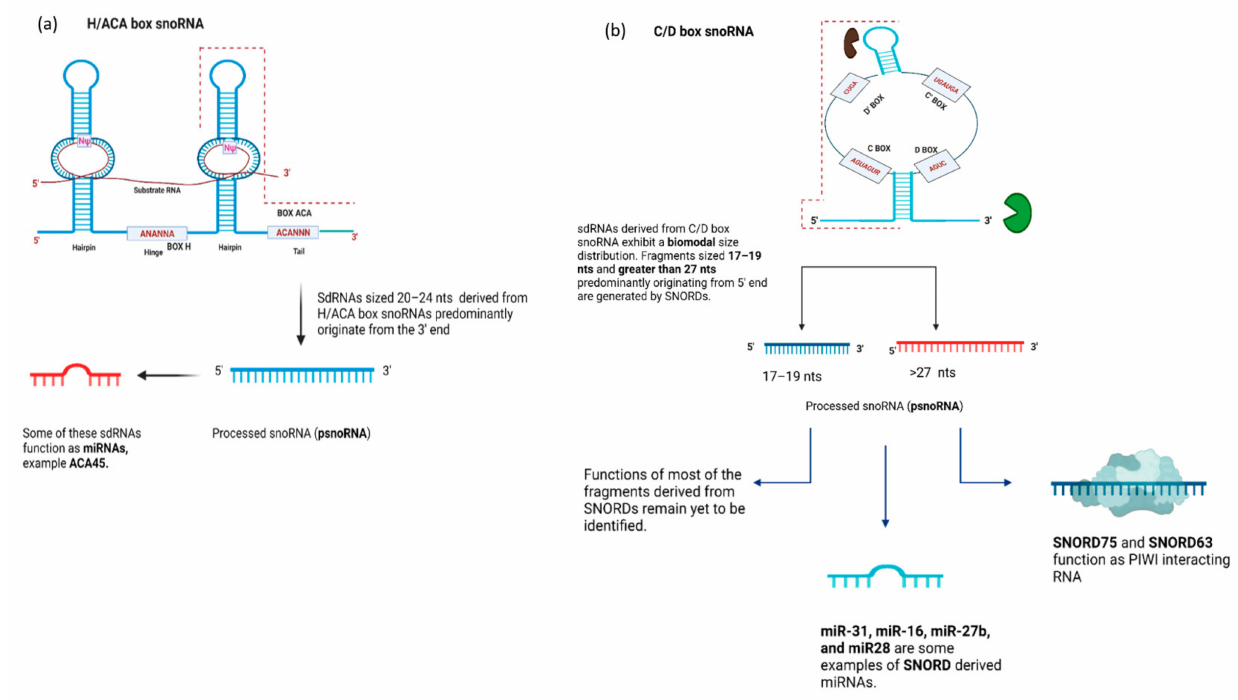
Figure 5. Fragments derived from C/D and H/ACA box snoRNAs: ( a ) The fragments generated by SNORA usually lie in a size range between 20 and 24 nucleotides [17]. There is evidence in the literature that some of these fragments act as miRNAs, an example of which is ACA45, a miRNA derived from H/ACA scaRNA15. ACA45 is around 20–22 nt in length, originating from the 3 (cid:48) half of the ACA part of the scaRNAs [25]. We know that ACA45 synthesis is DICER-dependent and DROSHA-independent. The processing enzymes for most of these sdRNAs are still unknown [10]. The functions of the other fragments derived from H/ACA snoRNA remain largely unknown [42]. ( b ) Fragments lying in two different size ranges are derived from SNORDs [17]. One group lies in the size range of 17–19 nt while the other group comprises sdRNAs that are greater than 27 nt. Additionally, there are reports that some of these fragments function as miRNAs [18], while some of the fragments act as piRNAs [27]. Nevertheless, the functions and the processing enzymes of most of the SNORD-derived fragments remain unknown